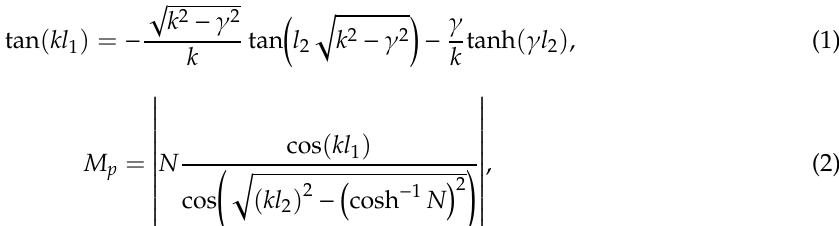
Figure 2. ( a ) Relationship between 𝐿 (cid:2869) and 𝐿 (cid:2870) ; ( b ) Relationship between 𝑀 (cid:3017) and 𝐿 (cid:2870) . Table 2. 1 stage horn parameters.